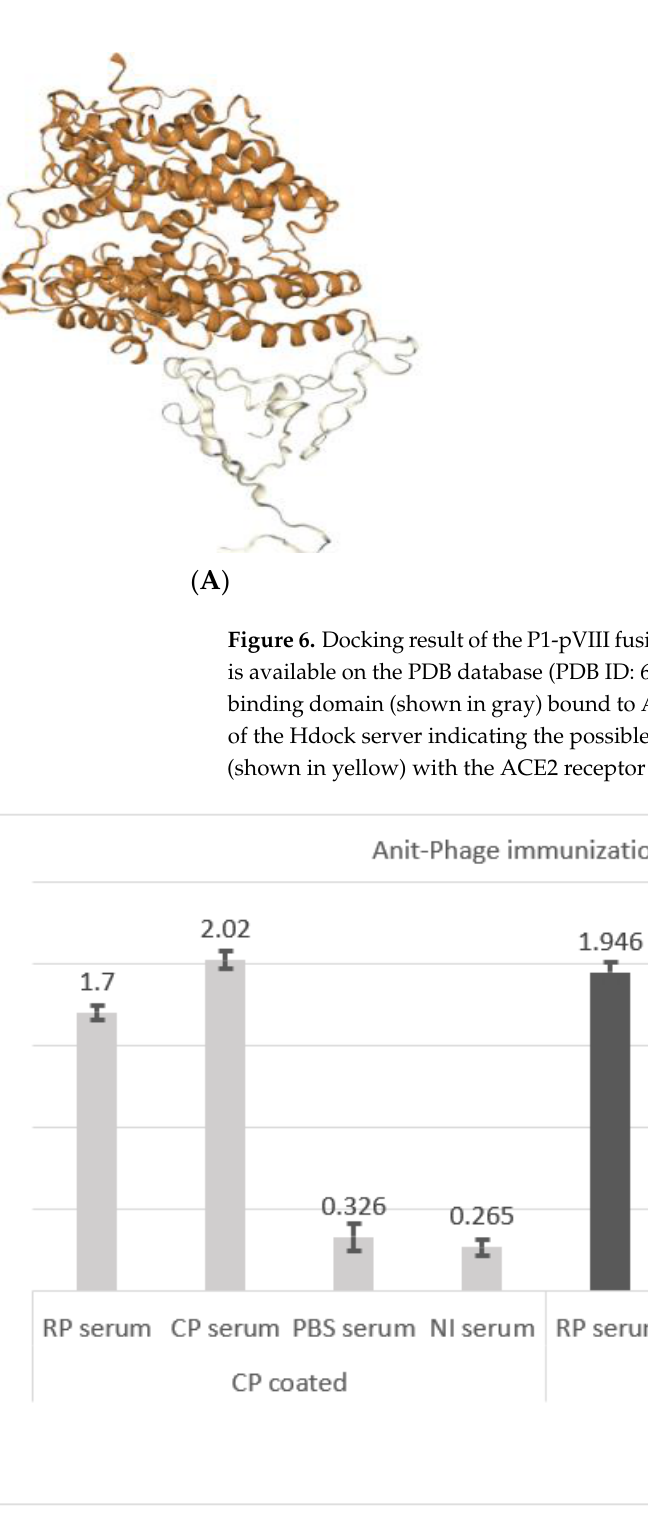
Figure 7. Immunization of mice against phage particles. Anti-phage antibodies were detected in both phage-inoculated groups of mice compared with the PBS and NI mice groups ( p -value < 0.05). Y -axis indicates optical density. Abbreviations: RP: P1 recombinant phage, CP: control phage, PBS: phosphate buffer saline, NI: non-injected.